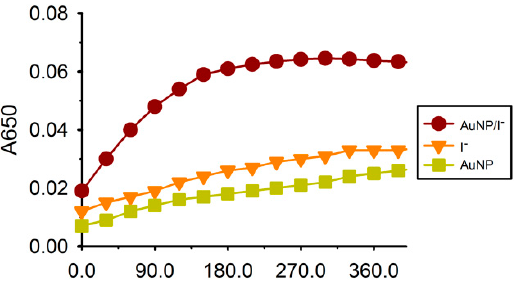
Figure 2. The time-absorbance curve of the TMB chromogenic reaction catalyzed by AuNP / I − , I − , and AuNP in 6 min.